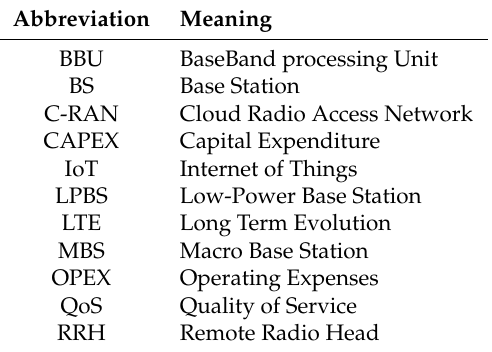
Table 1. Summary of